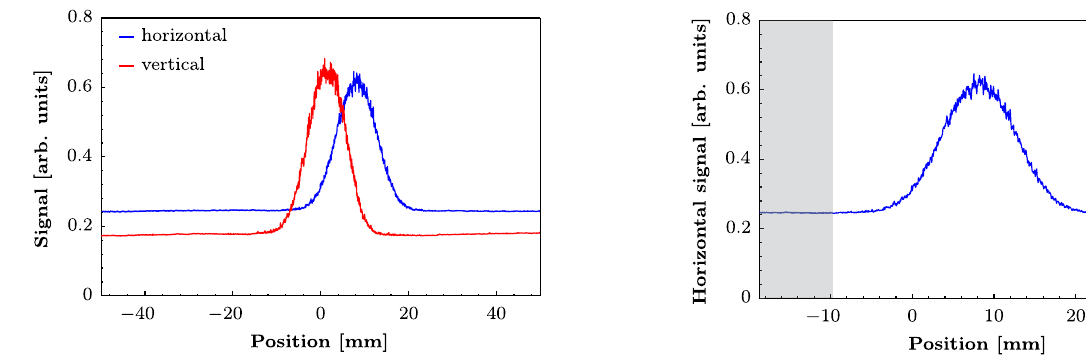
FIG. 21. This profile corresponds to the horizontal one of Fig. 20; however, only data points within the restricted interval ½ − 6 σ 1 þ μ 1 ; 6 σ 1 þ μ 1 (cid:2) are shown. The shaded areas indicate data points, which are considered for the evaluation of the baseline using F 2 ð z Þ .